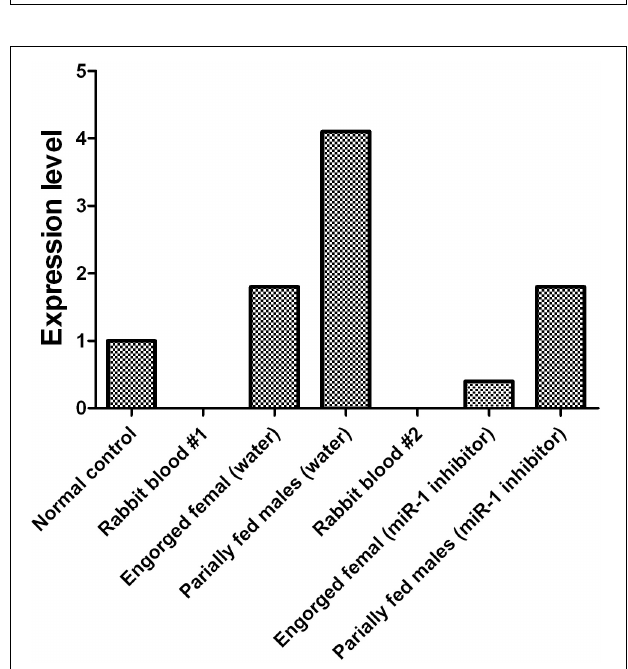
FIGURE 10 | Before and after inhibition of miR-1, dynamic expression during tick engorgement was determined. Rabbit blood and water were used as